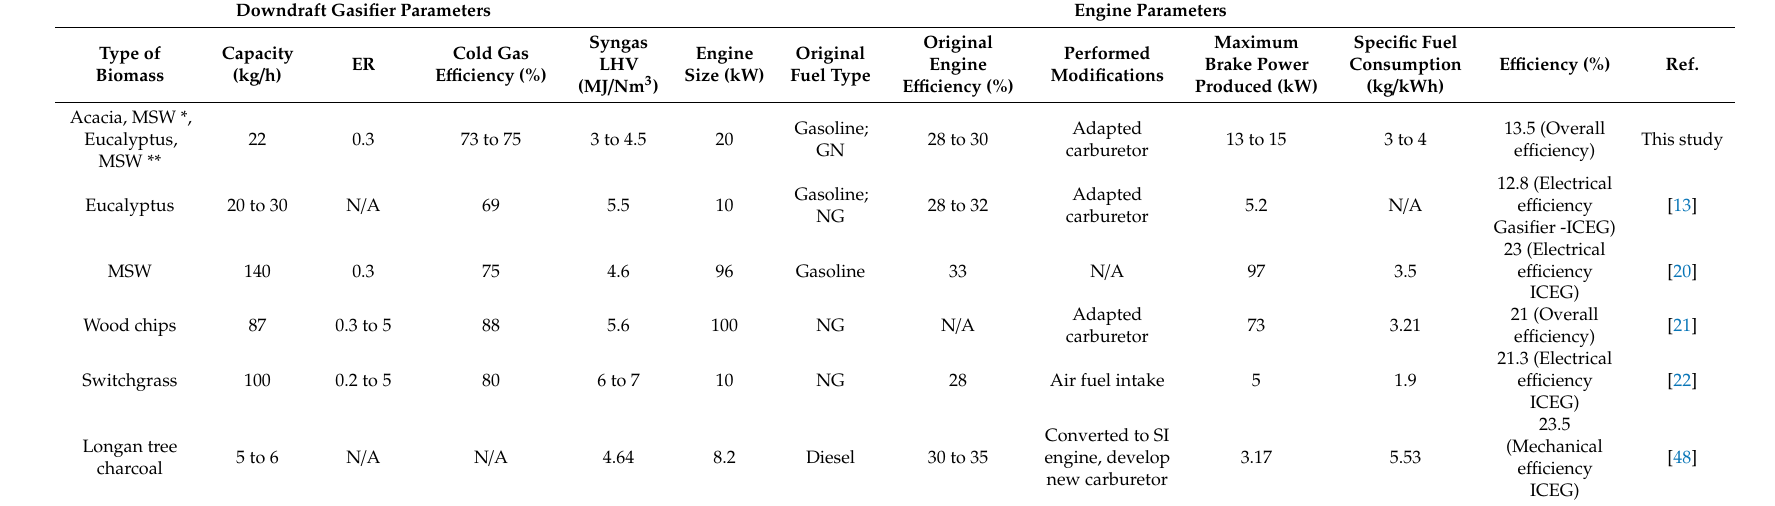
Table 9. Various studies performed with downdraft gasifiers coupled with ICEG using 100%